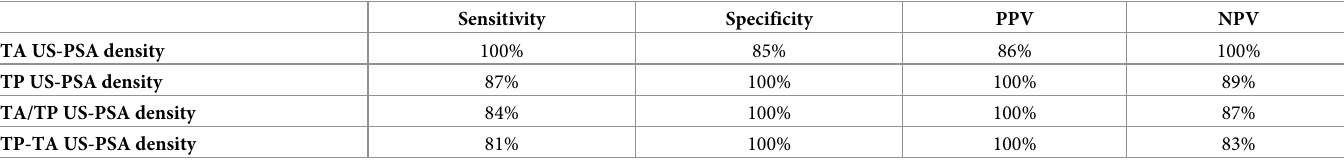
Table 7. Sensitivity, Specificity, Positive predictive value (PPV), Negative predictive value (NPV) between MRI-PSA density and each US PSA density for the deci- sion to biopsy at PSA threshold > 0.12 ng/mL 2